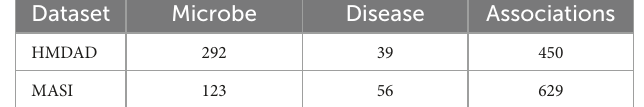
TABLE 1 The overall statistics for the microbe-disease association dataset. Dataset Microbe Disease